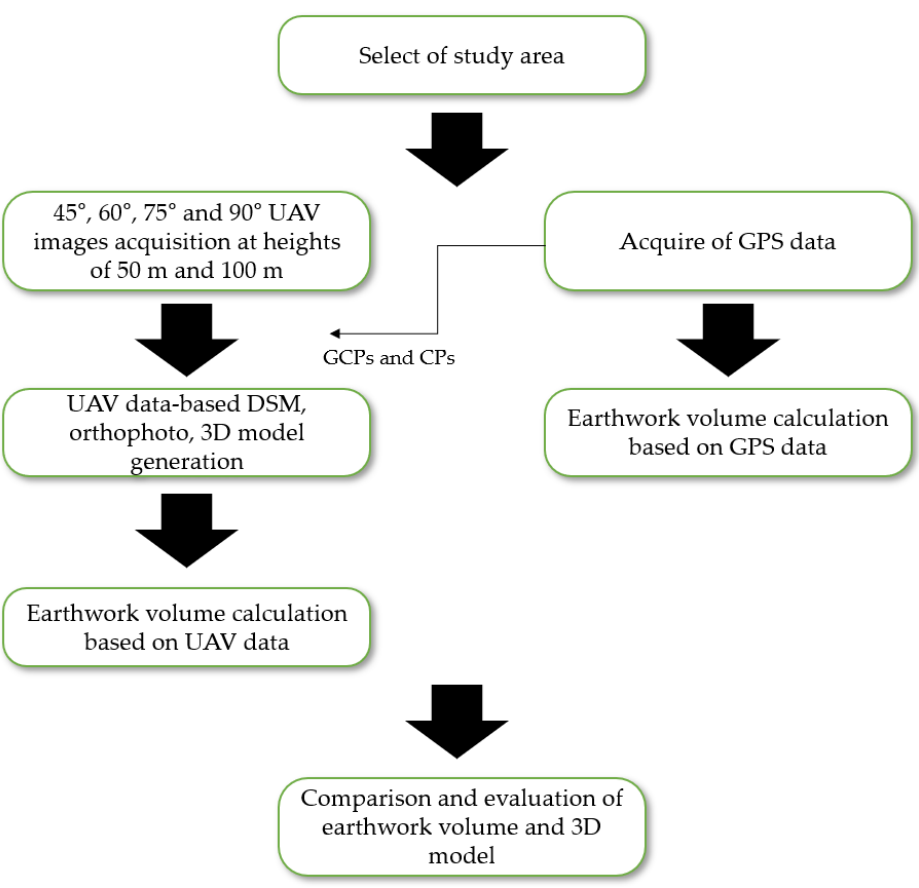
Figure 1. Research flow